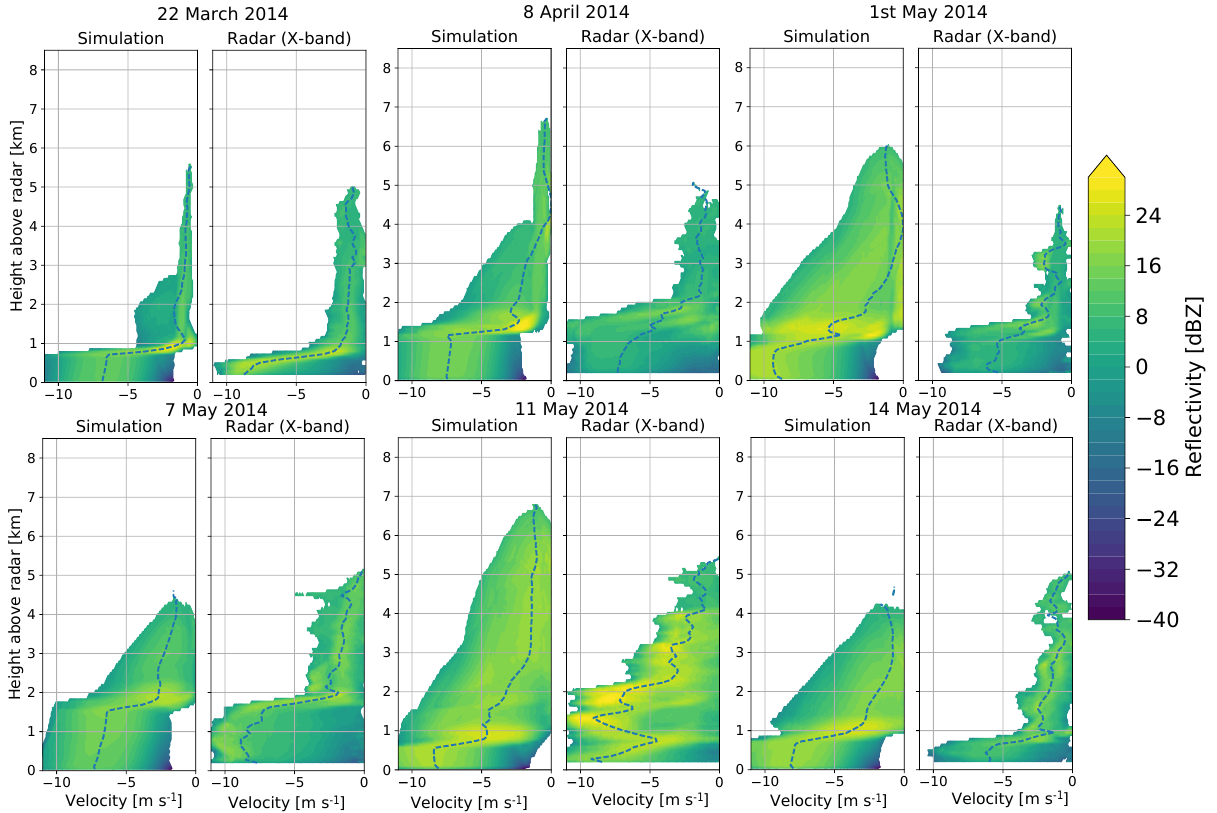
Figure 16. Simulated and measured daily averaged Doppler spectrum at X-band at vertical incidence during 6 days of precipitation in Western Switzerland. The dashed line represents the radial velocity calculated from the spectrum (Eq. 47).